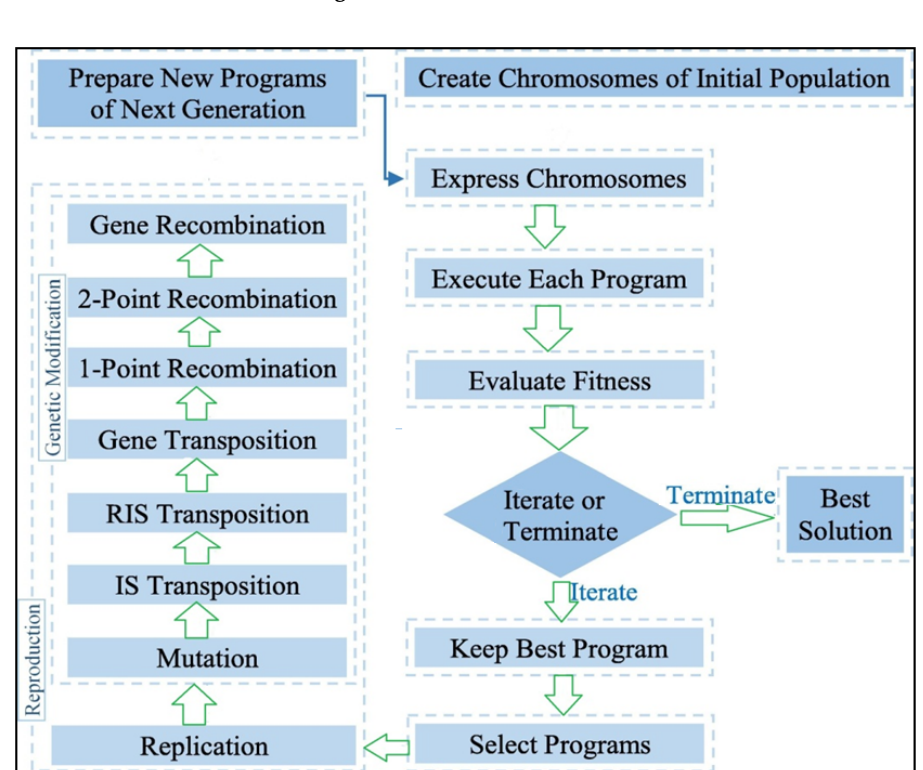
Figure 6. Scheme of gene expression programming.